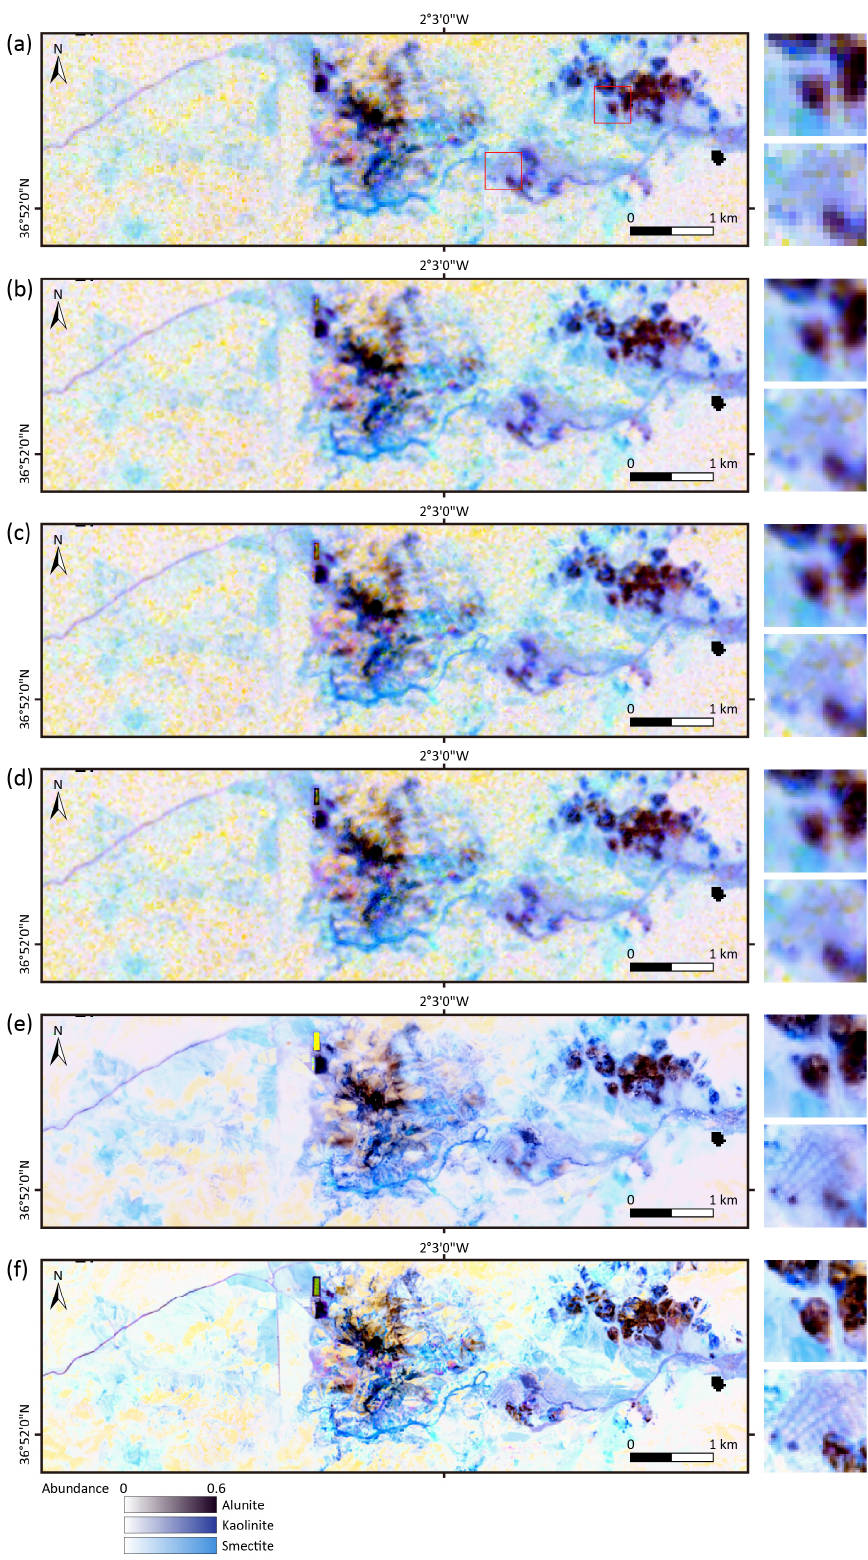
Figure 4. Color composite images (R: 2201 nm, G: 2159 nm, B: 2115 nm) of continuum removed images obtained by ( a ) nearest-neighbor interpolation; and ( b ) bicubic interpolation of EnMAP data; and fusion of EnMAP and Sentinel-2 data using ( c ) GSA; ( d ) MTF-GLP; ( e ) CNMF; and ( f ) reference data. Black, blue and light blue are corresponding to alunite, kaolinite and smectite, respectively.